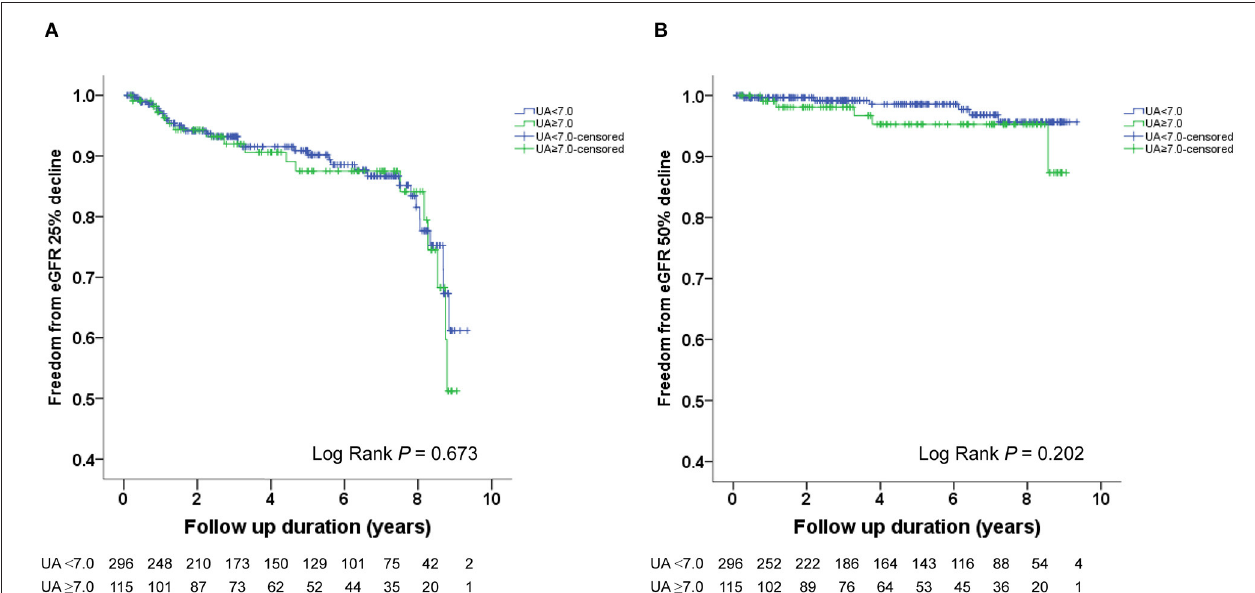
FIGURE 3 | Kaplan-Meier survival curves showing the absence of renal events according to the baseline uric acid (UA) in patients with hypertension. All participants were divided into two groups according to UA levels. The blue line represents the patient group with UA < 7.0 mg/dL. The green line represents the group with UA ≥ 7.0 mg/dL. Renal events were defined as > 25% decline and > 50% decline in eGFR. Differences were compared using the log-rank test. (A) UA ( < 7.0 vs. ≥ 7.0 mg/dL) and > 25% decline in eGFR ( P = 0.673). (B) UA ( < 7.0 vs. ≥ 7.0 mg/dL) and > 50% decline in eGFR ( P = 0.202).